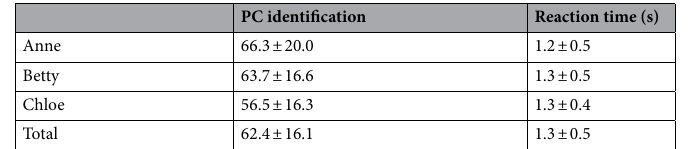
Table 3. Behavioural results. Mean percent correct scores (PC) with relative standard deviation averaged and mean reaction times with relative standard deviations obtained in the fMRI session (averaged over the four runs).